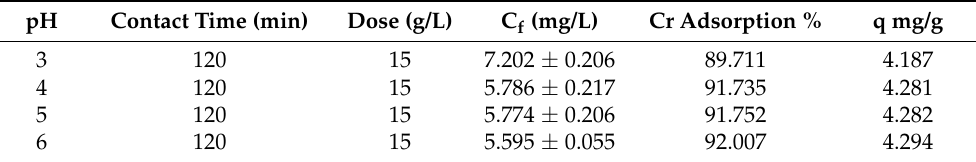
Table 3. Effect of pH on Pb 2+ removal efficiency (C o = 70 mg/L, agitation speed = 150 rpm).